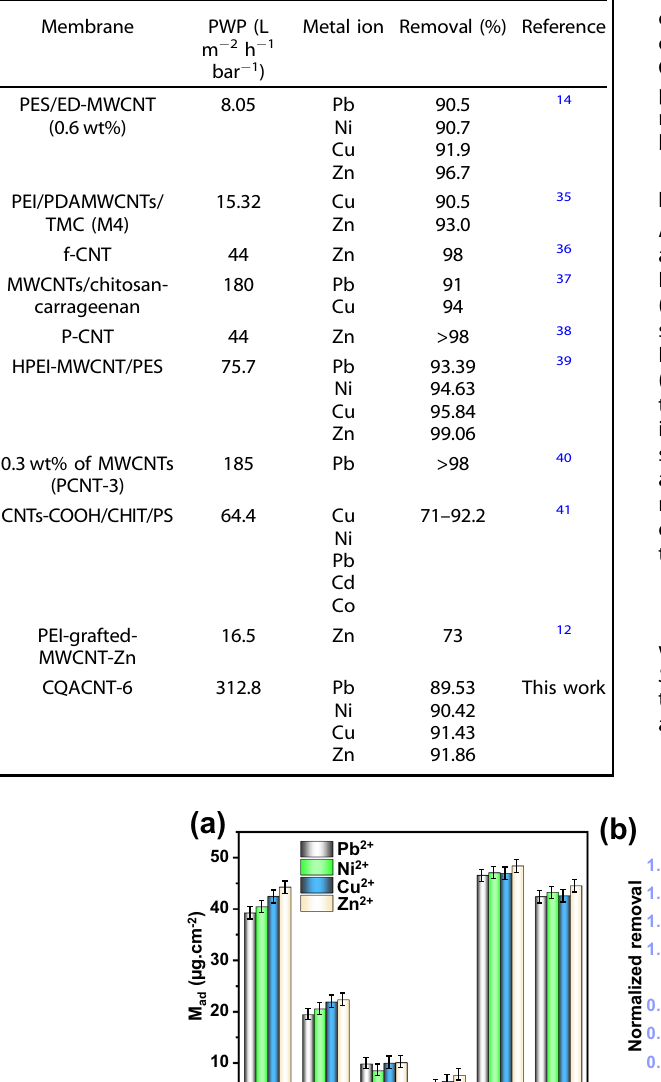
Table 1. Comparison among MWCNT porous membranes reported in the literature and in this work for the removal of toxic